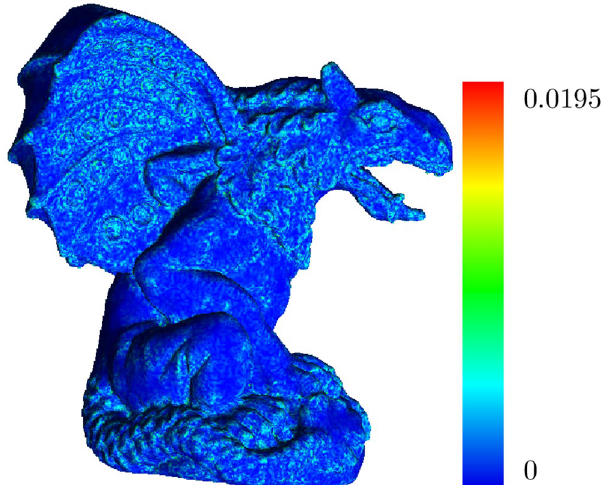
Fig 7. The geometric deviation of a simplified version of the Gargoyle model at 10% of its original number of vertices.